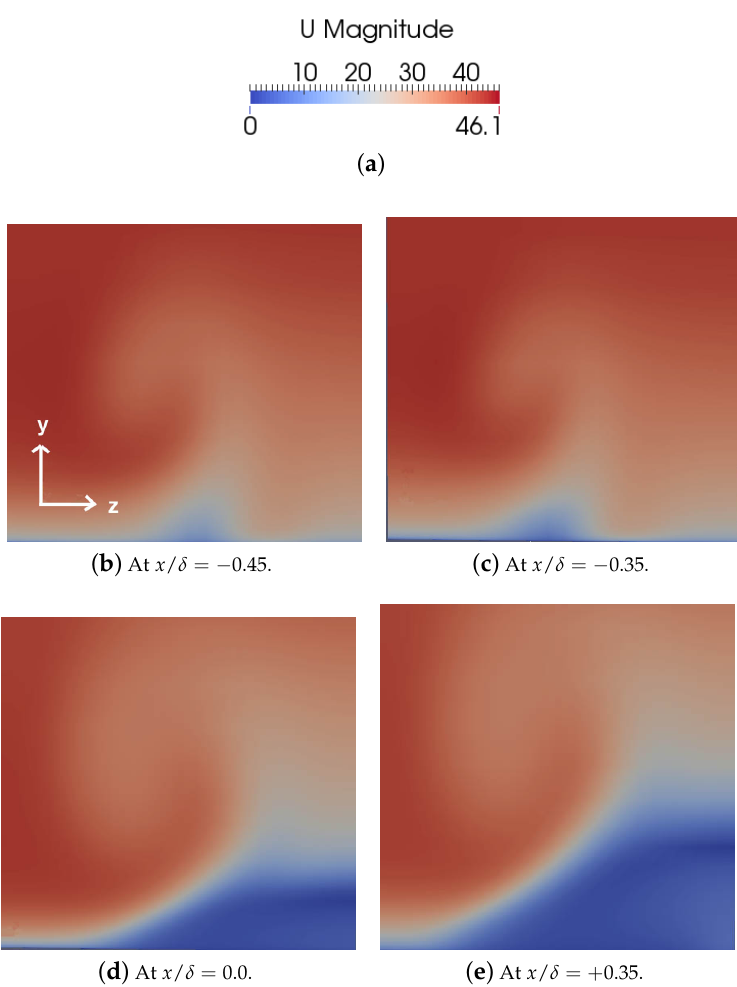
Figure 7. Velocity distribution (m · s − 1 ) at planes normal to the streamwise direction and located at normalized distances x / δ from the backward-facing ramp where the origin is placed. H 1 = 0.8 δ vane-type VG